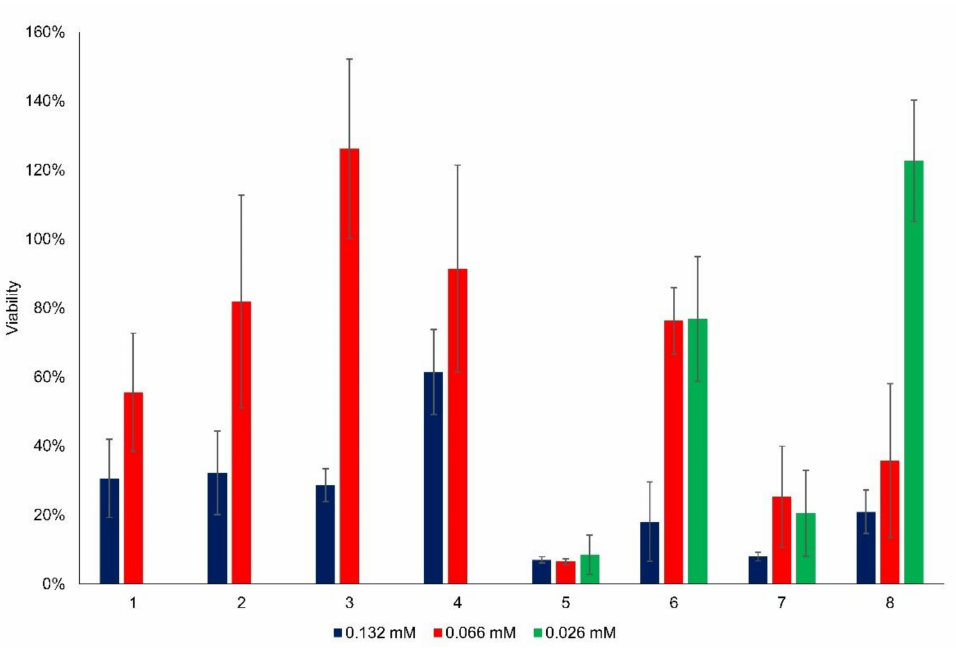
Figure 3. Viability (%) of HCT116 cells as a function of flavylium concentration.